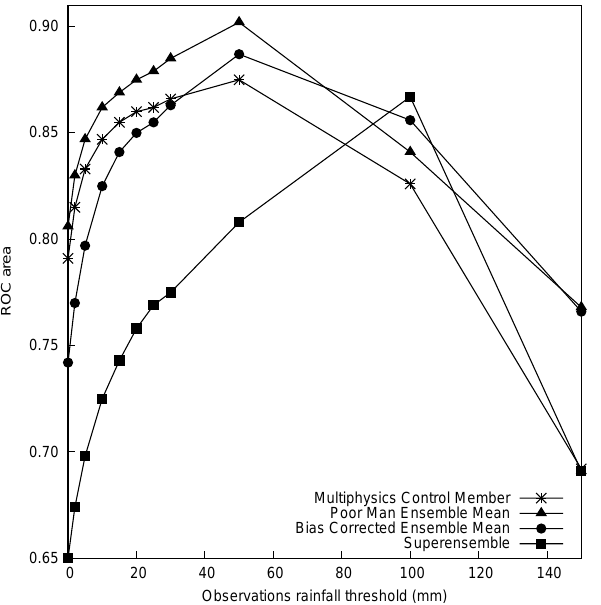
Fig. 7. Bias for the multiphysics ensemble control member, the multiphysics ensemble mean, the bias corrected ensemble mean and the superensemble, as functions of different rainfall event thresholds. Note: training period 19 MEDEX cases and forecast period September–December 2001.